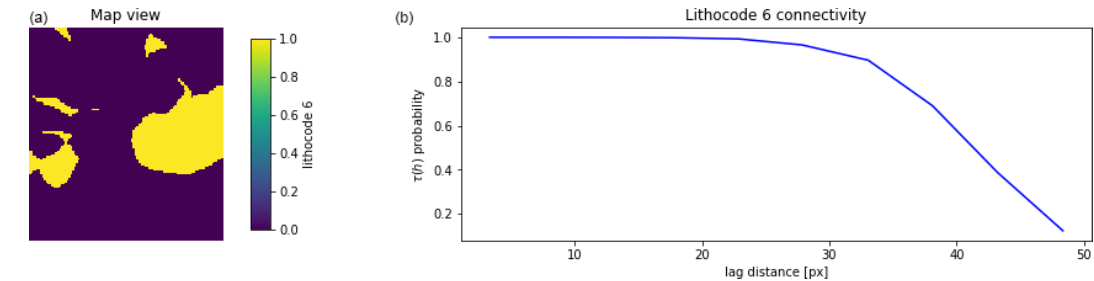
Figure 9. Illustration of the τ( h ) connectivity function (b) computed on a 2D horizontal section from a binary 3D voxet (a) .